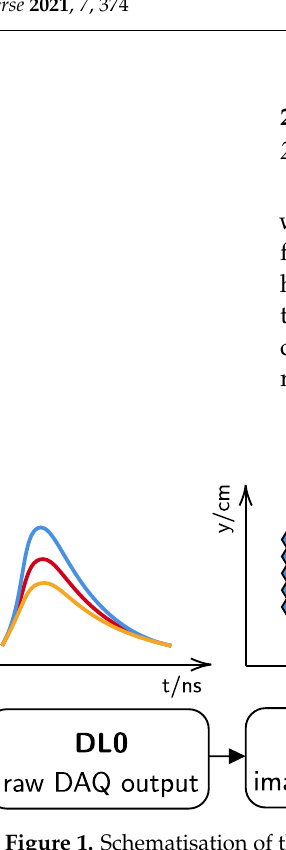
Figure 1. Schematisation of the progressive data reduction and data levels of an IACT. Raw data contain the signal sampled from the photomultipliers at the occurrence of a trigger event (Data Level 0). Calibrated data (Data Level 1) contain the pixelated image of the Cherenkov light of the shower. The latter can be parametrised with few geometrical quantities and used to determine the observables of the original shower, including its probability of being a gamma-ray shower (Data Level 2). The detected events can be gathered in a list of gamma ray candidates, together with the functions representing the response of the system (the so-called instrument response function, IRF), e.g., the collection area of the system as a function of the energy or the bias of its energy reconstruction (Data Level 3). This information can be used to perform a statistical analysis obtaining the so-called science products, in this case the spectrum of the source (Data Level